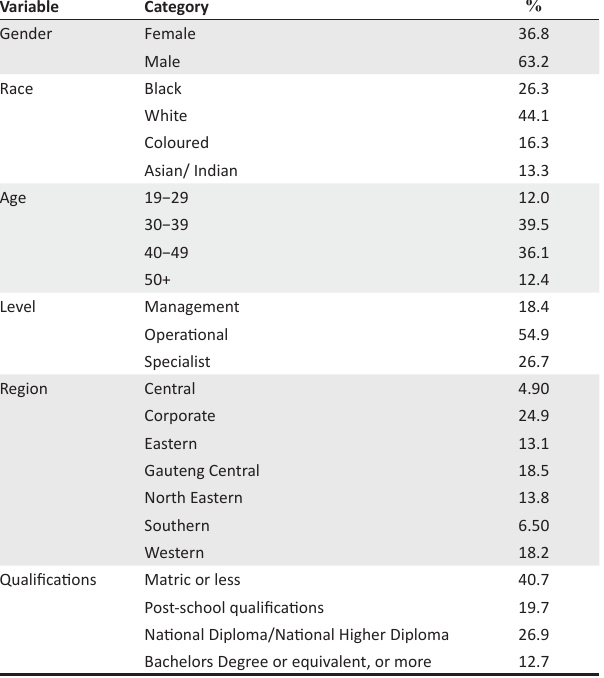
TABLE 1: Biographical and demographical details of the participants ( n = 2429).